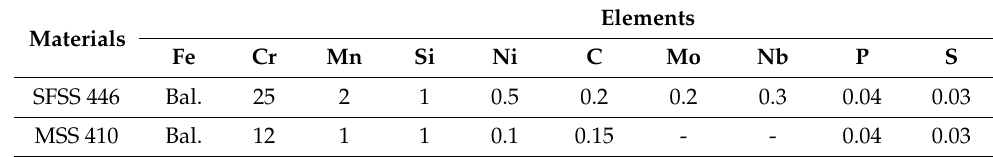
Table 1. Chemical compositions of super-ferritic 446 and martensitic stainless steel 410 (wt.%).